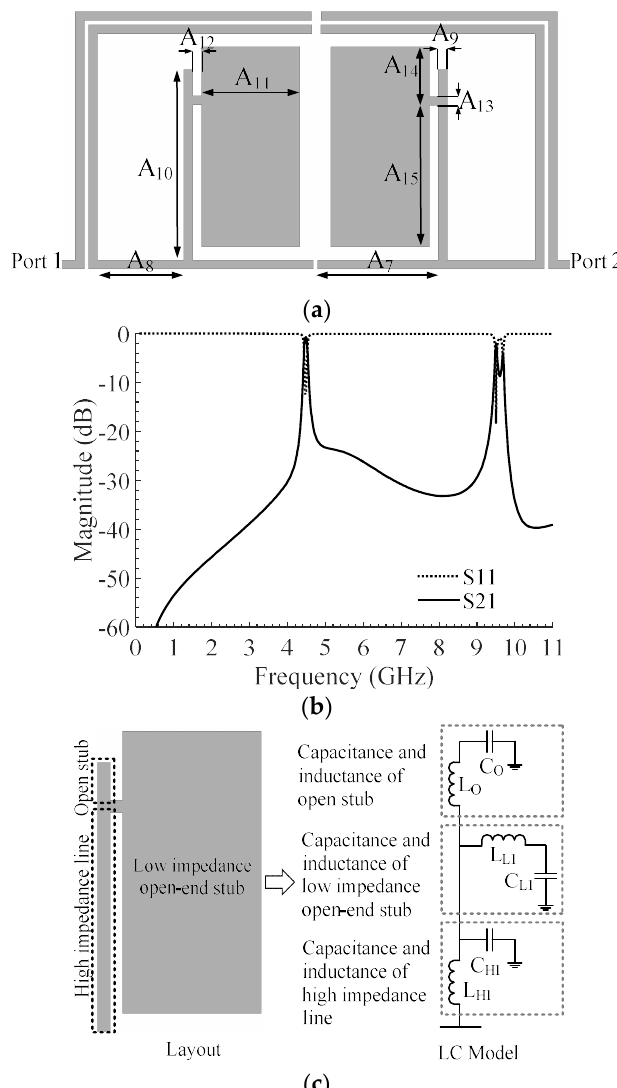
Figure 5. Integration of flag-shaped resonators with the bended coupled system. ( a ) Layout, ( b ) EM simulation, ( c ) LC model of flag-shaped resonator. The dimensions of the introduced flag-shaped resonators are as follows: A 7 = 2.7, A 8 = 1.9, A 9 = 0.2, A 10 = 4.3, A 11 = 2.2, A 12 = 0.2, A 13 = 0.2, A 14 = 1.32, A 15 = 3.2 (all in mm).